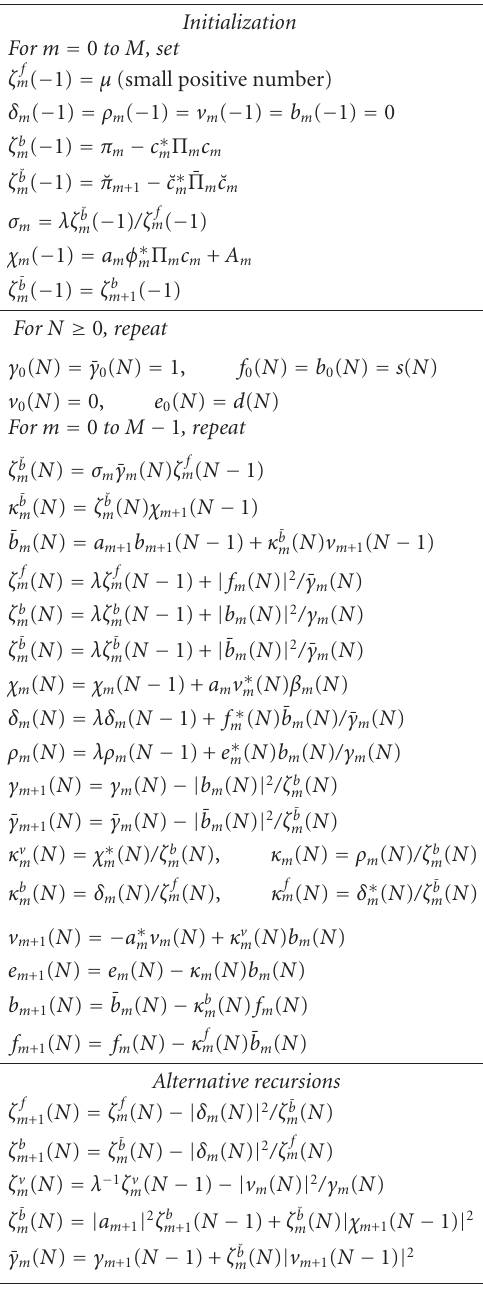
Algorithm 1: Standard extended RLS lattice recursions.